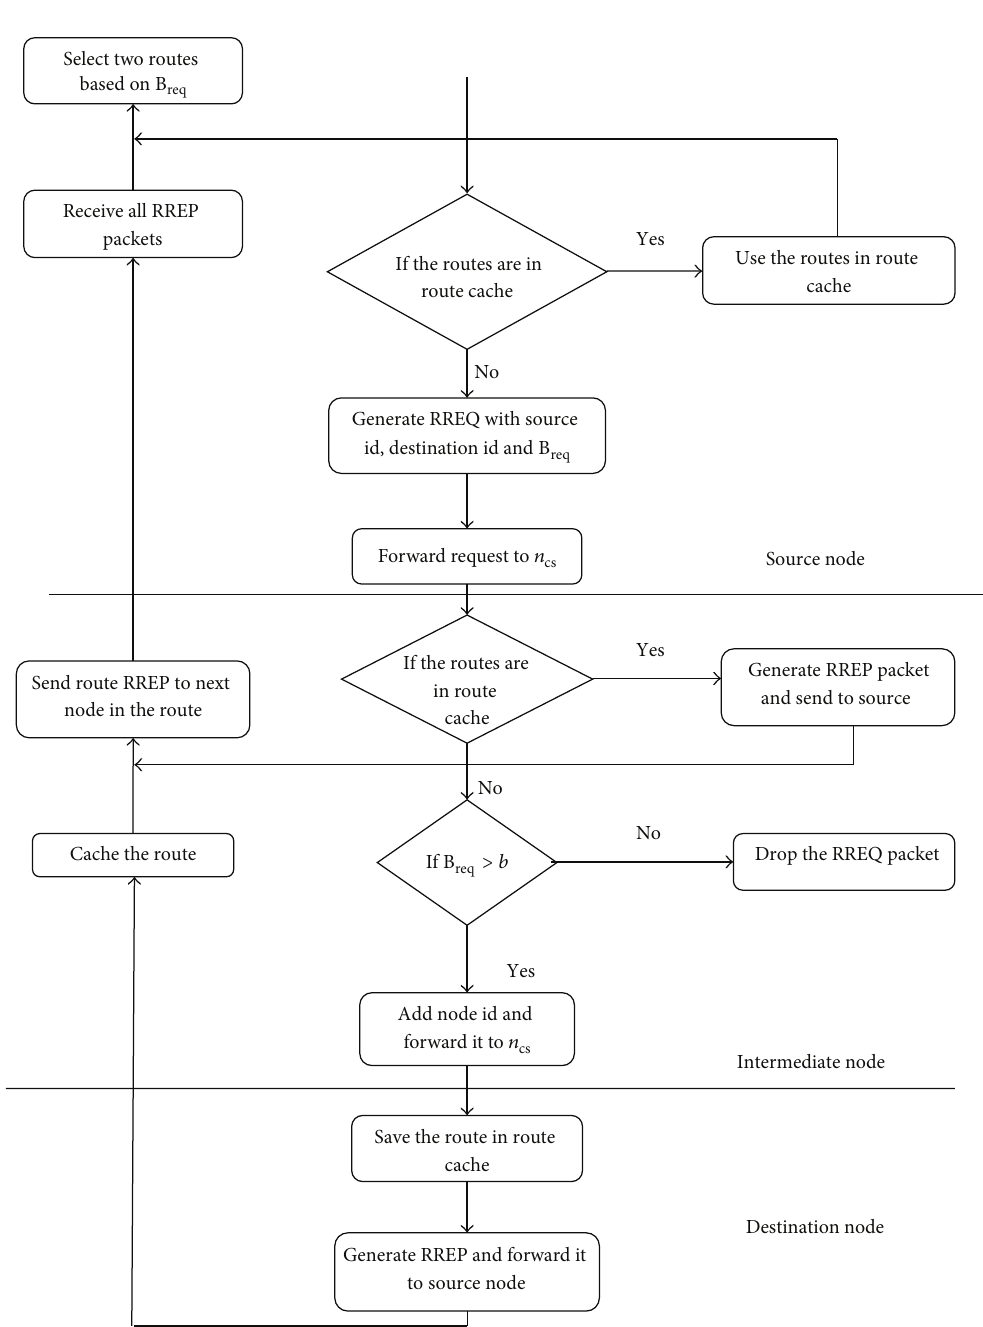
Figure 1: Capacity constraint route discovering